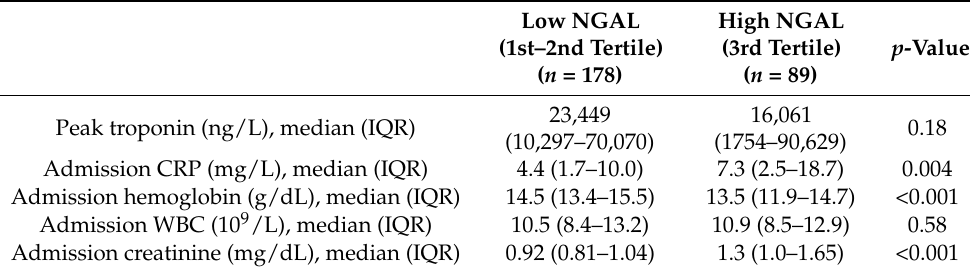
Table 2. Laboratory parameters stratified by NGAL